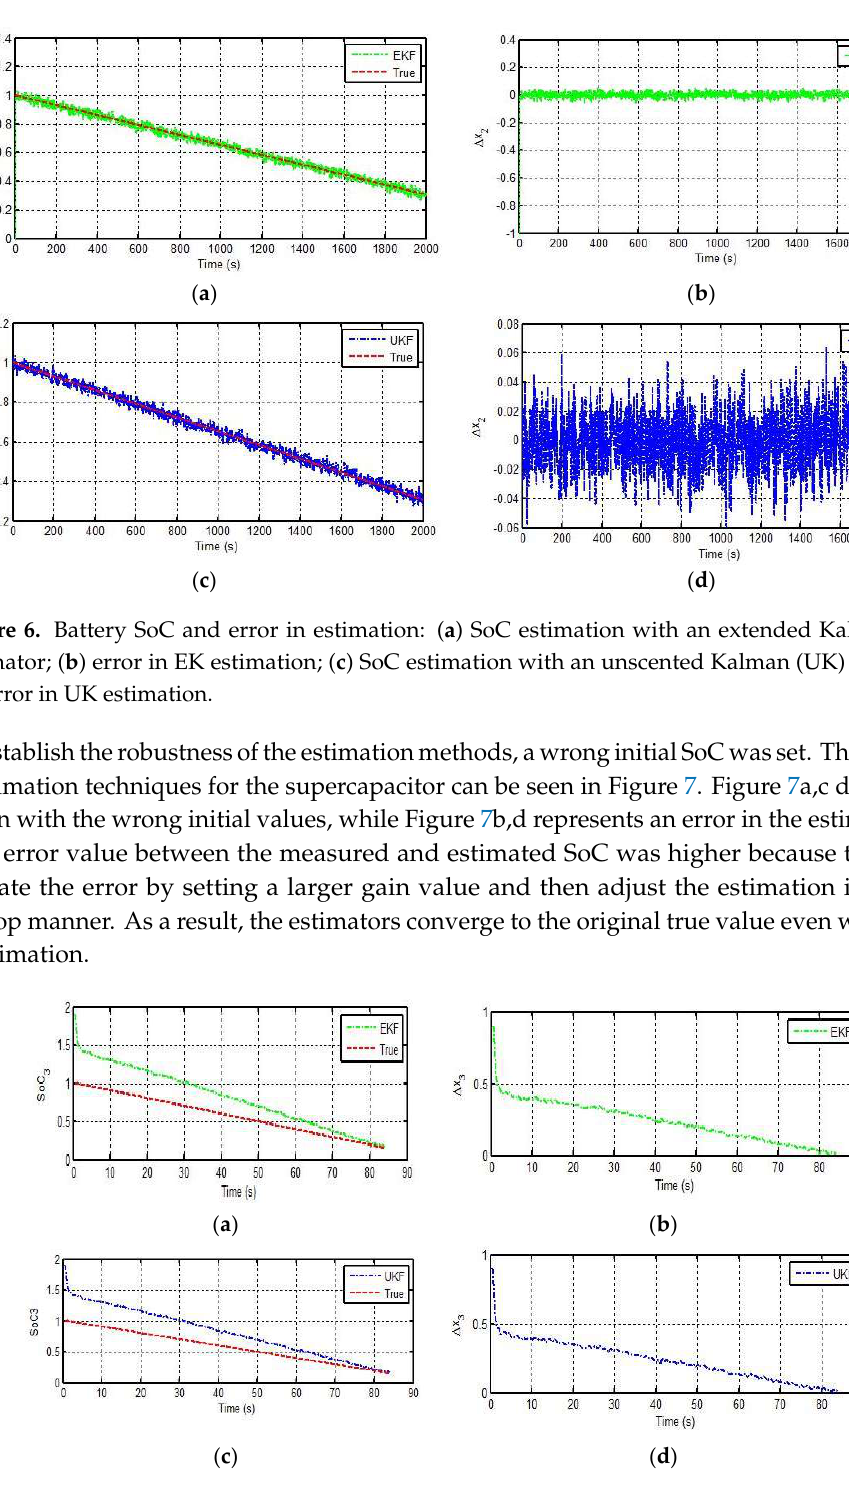
Figure 7. Supercapacitor SoC and error in estimation: ( a ) SoC estimation with an EK estimator; ( b ) error in EK estimation; ( c ) SoC estimation with a UK estimator; ( d ) error in UK estimation. .